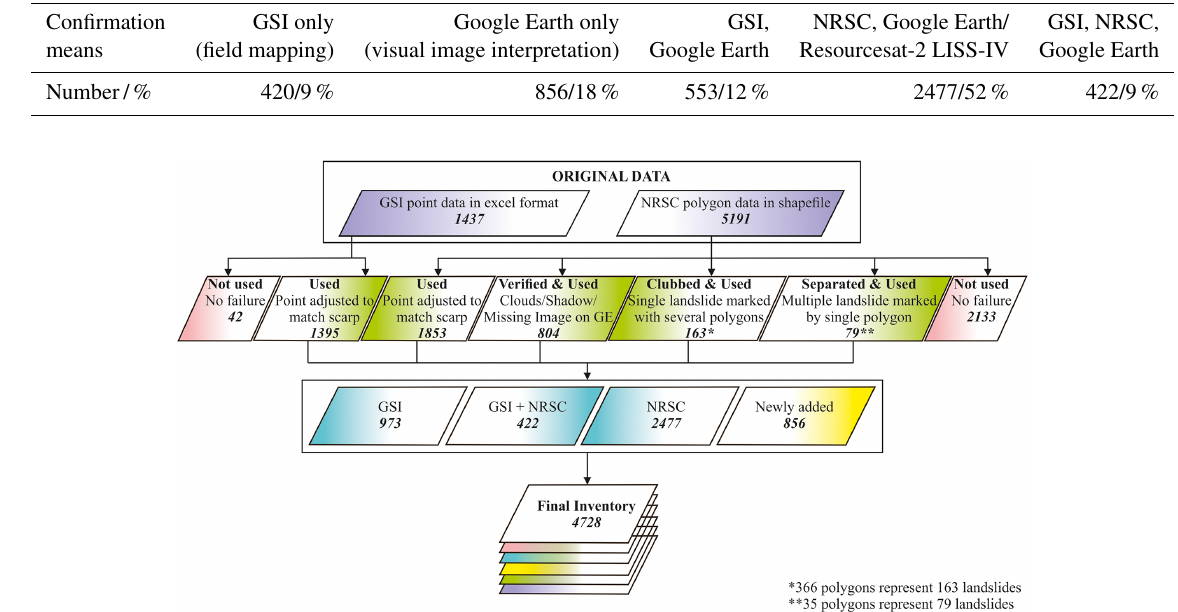
Figure 18. Overview of the procedure to generate the complete landslide inventory with the number of landslides